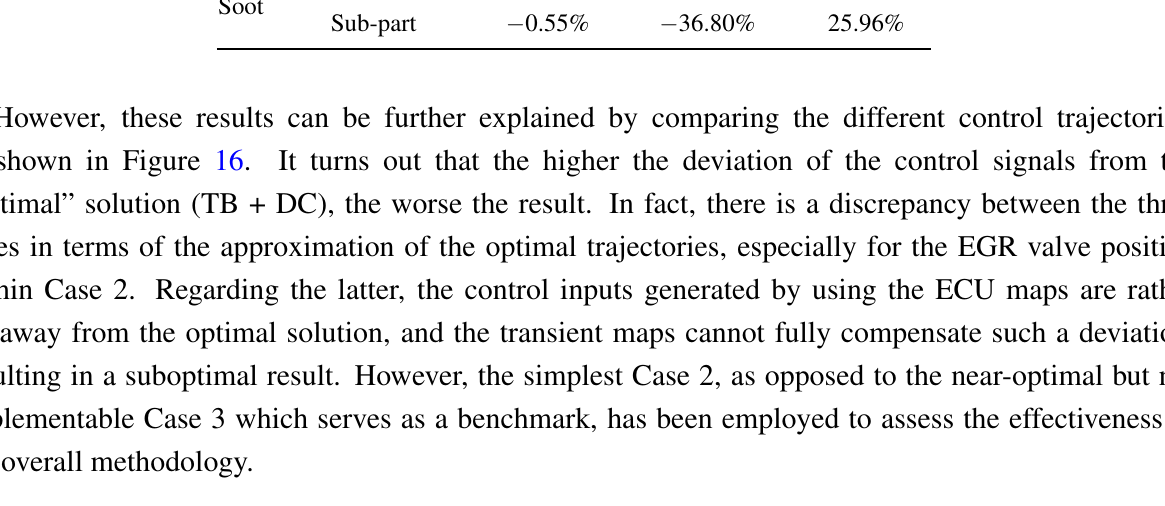
Figure 16. Comparison between the three cases